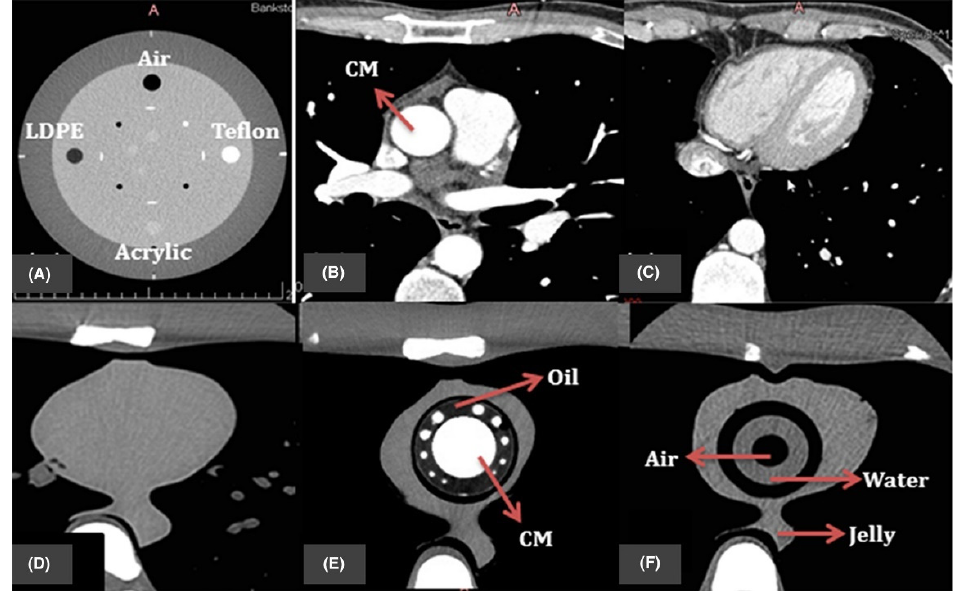
Figure 10. The resulting axial CT of ( A ) four inserts in Catphan@ 500 phantom; ( B , C ) patient image datasets for cardiac CT; ( D ) original cardiac insert of anthropomorphic chest phantom; ( E , F ) 3D printed cardiac insert phantom with contrast materials (CM), oil, air, water and jelly segmented labeled. Reprinted with permission under the open access from Abdullah et al. [81].